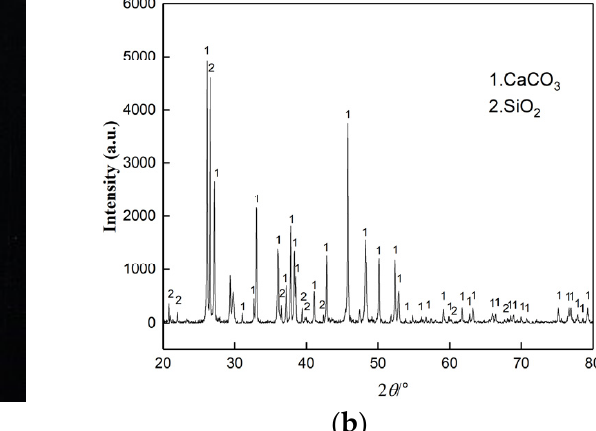
Figure 2. Samples: ( a ) Calcareous sandstone samples used in this study (particle size = 0.075–5 mm); ( b ) XRD spectra.